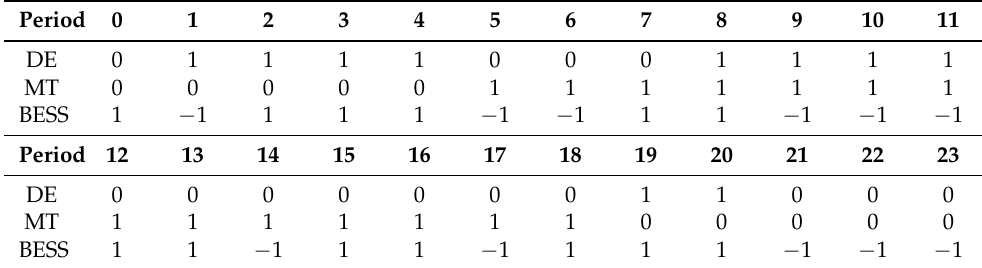
Table 5. The on–off status of the units each time period of the day using the